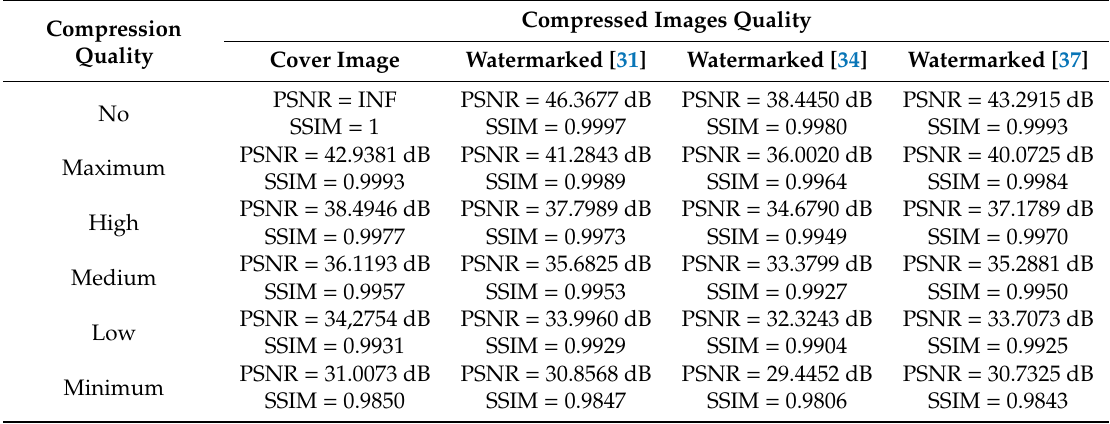
Figure 8. Watermark ( a ) and watermarked images obtained using ( b ) algorithm [31]; ( c ) algorithm [34]; ( d ) algorithm [37]. Table 1. Compressed images quality